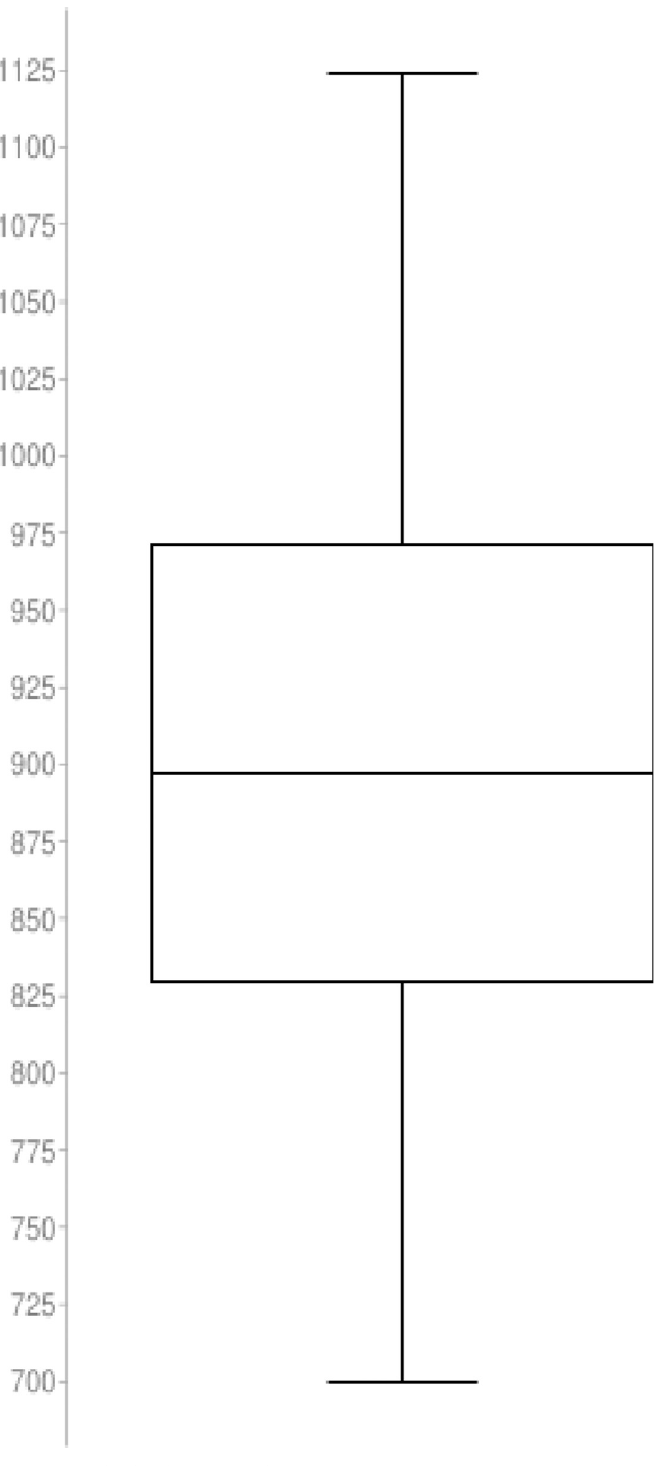
Fig 36. Boxplot for the QA